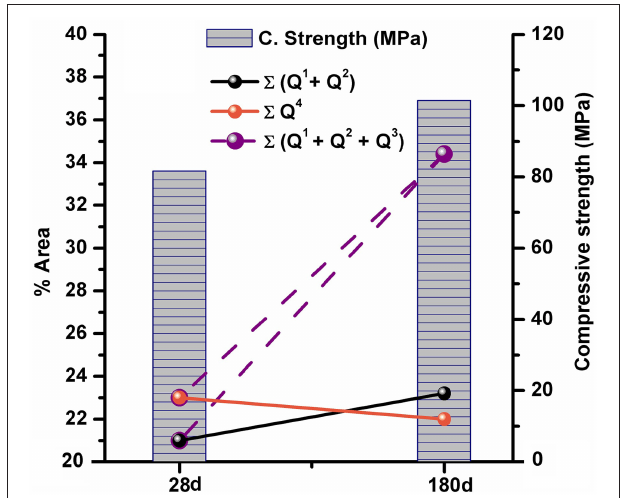
FIGURE 5 | Total areas of Q 1 , Q 2 , Q 3 , and Q 4 units on the 28 d and 180 d 29 Si MAS NMR spectra and compressive strength of 3x3x3cm paste